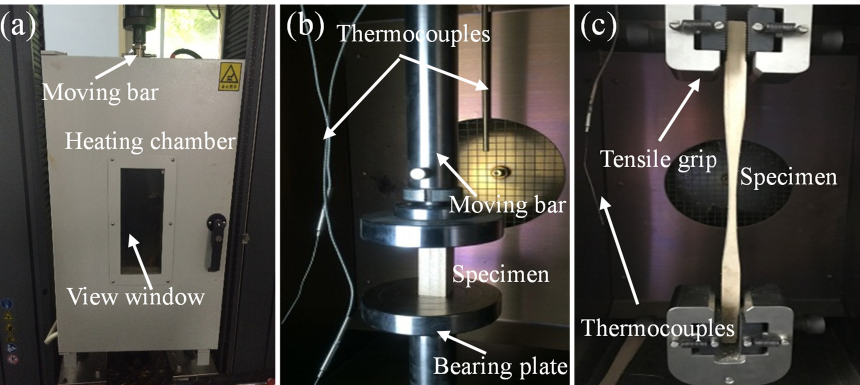
Figure 2. Experimental set-up: ( a ) heating chamber; ( b ) compressive configuration; and ( c ) tensile configuration.